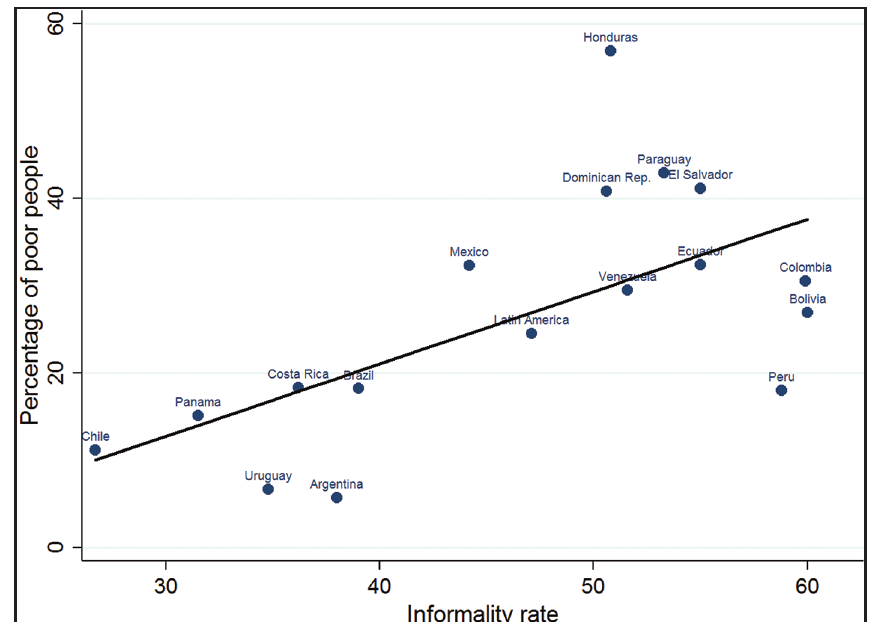
Figure 1 Poverty and informality in Latin American